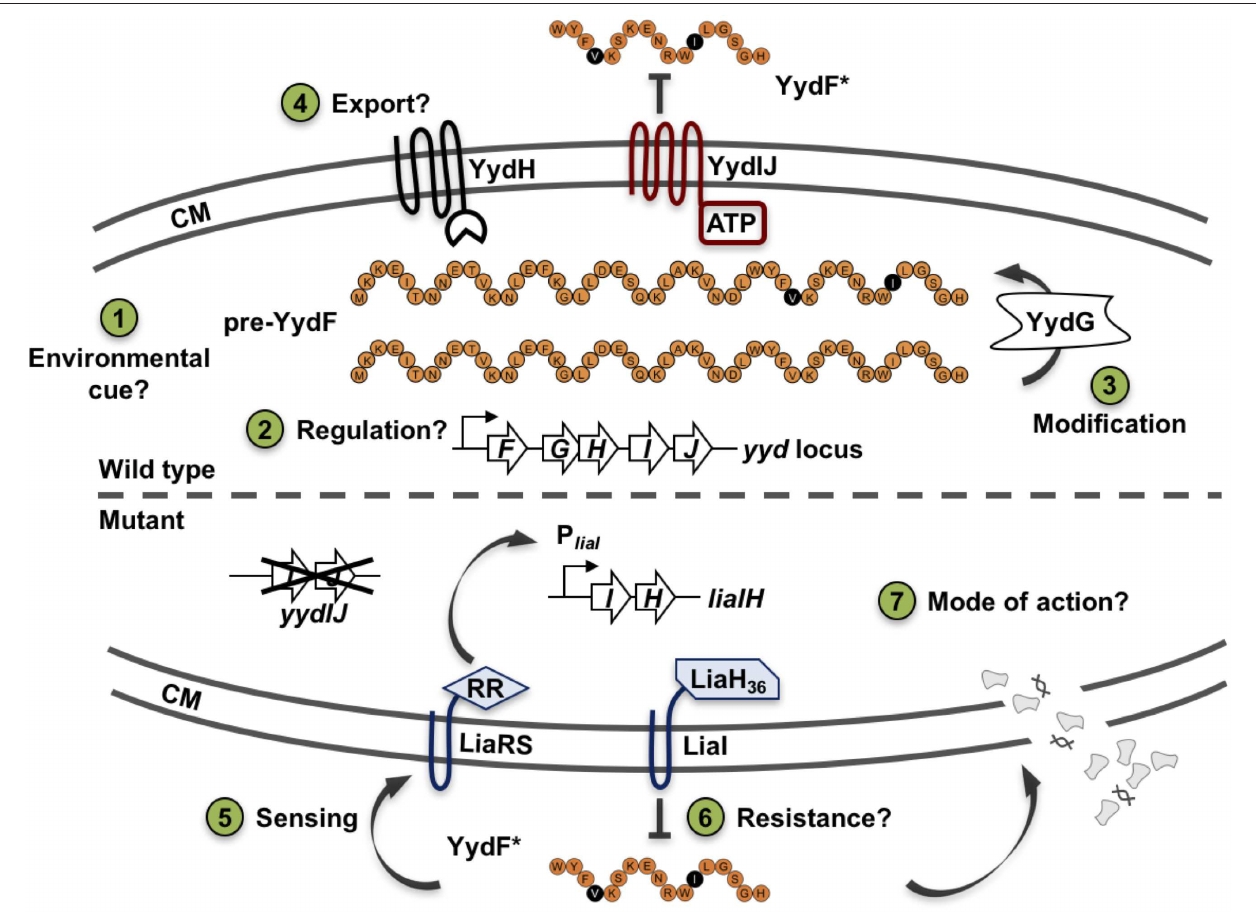
FIGURE 1 | Schematic overview of the yydFGHIJ operon in B. subtilis. In the wild type (1–4), at transition from exponential to stationary phase a yet unknown cue triggers expression of the yyd operon (1). P yydF is described as a constitutive σ A -dependent promoter, details on any regulation beyond that are still missing